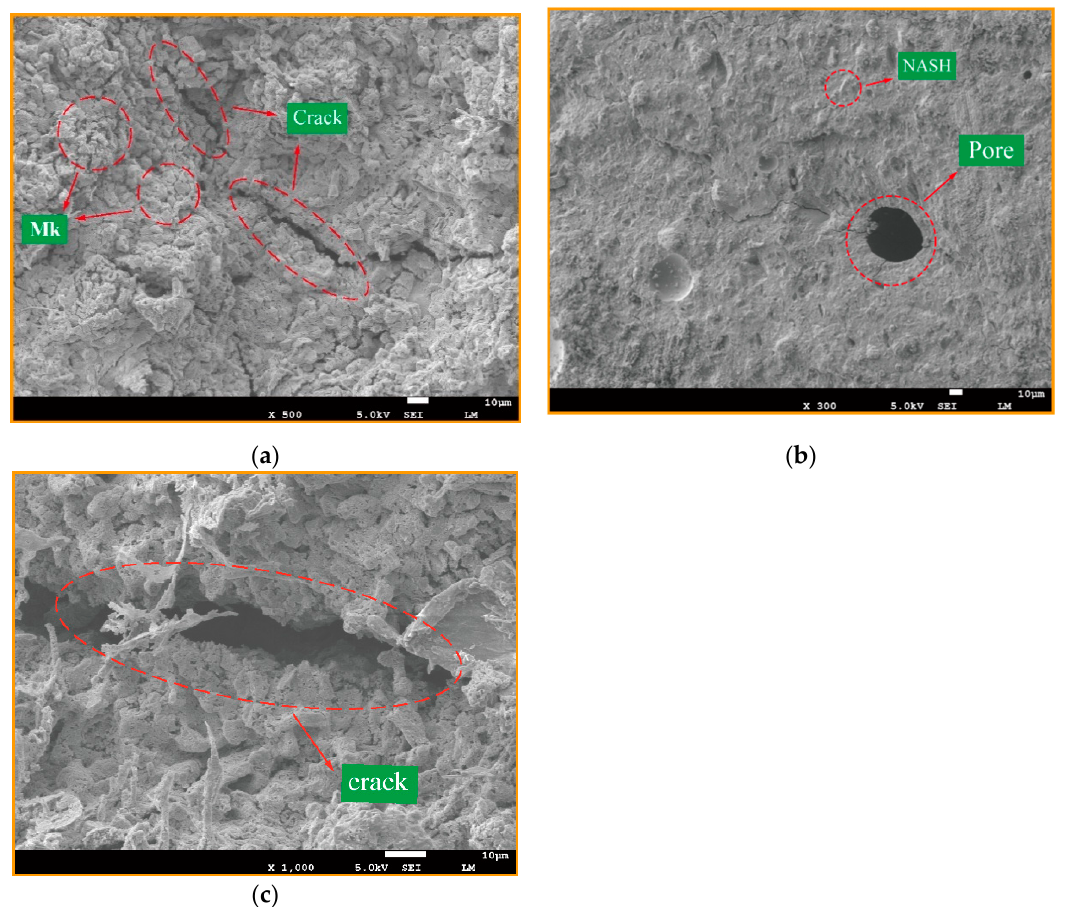
Figure 10. SEM micrographs of geopolymers synthesized at Na/Al, with fixing the Si/Al molar ratio, ( a ) Na/Al = 0.43, ( b ) Na/Al = 0.73, ( c ) Na/Al = 0.93.